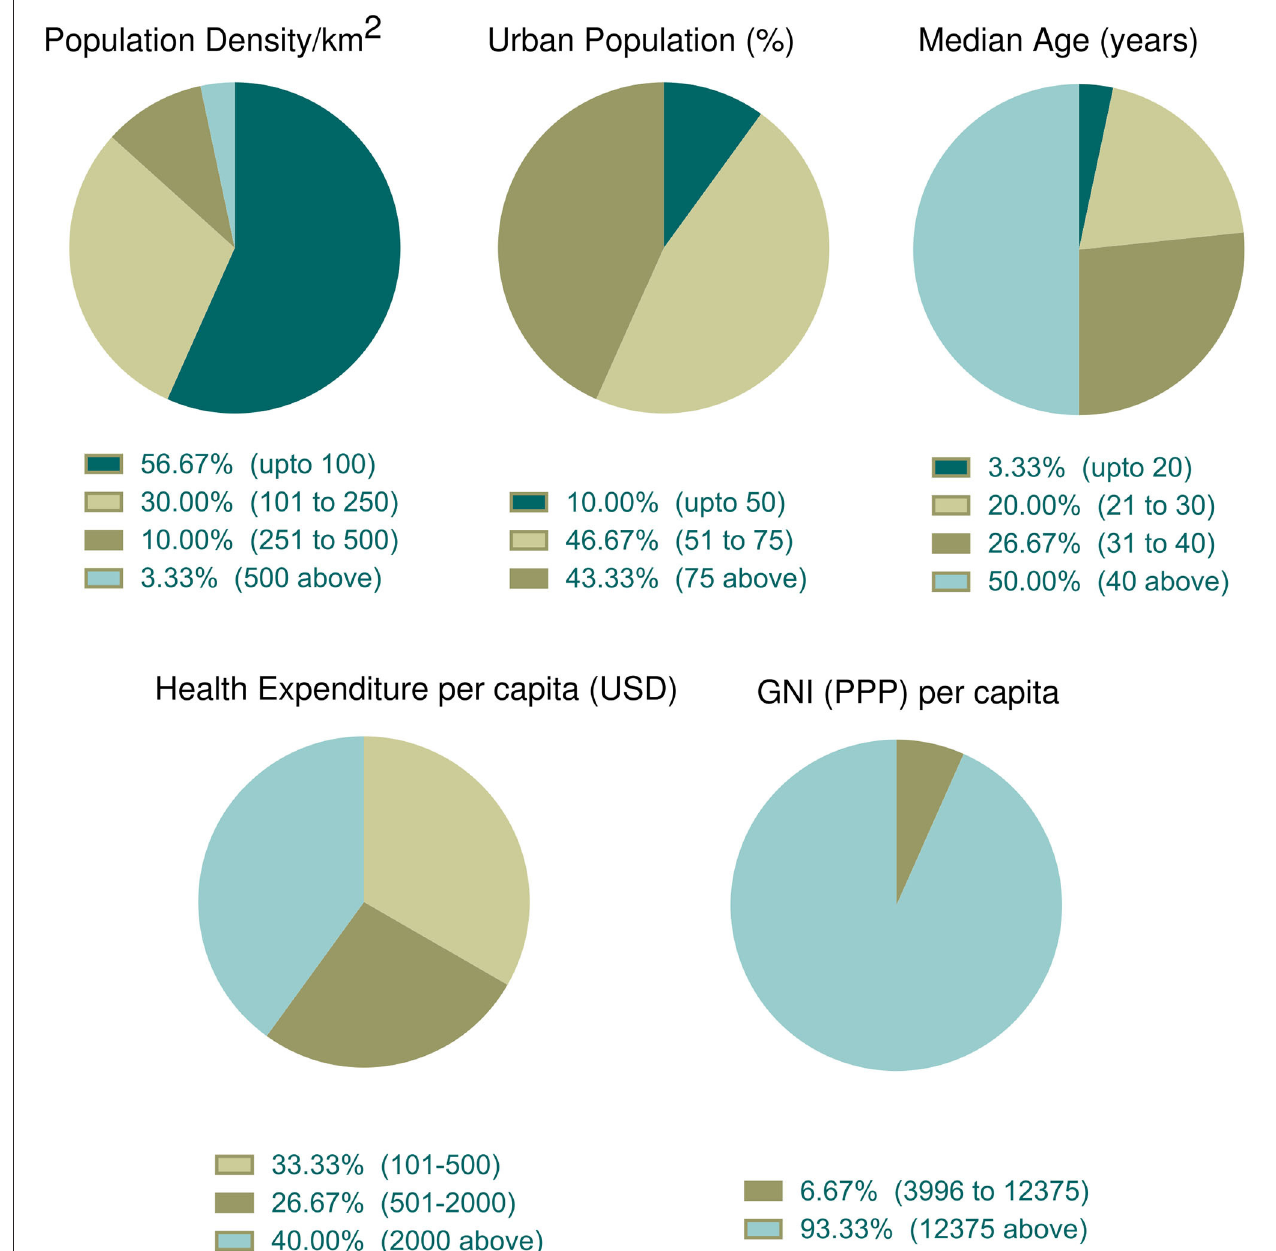
FIGURE 6 | Incidence of socioeconomic and demographic parameter distribution among the top thirty countries with high case fatality (%). Data categories with zero data are not shown in the pie chart.